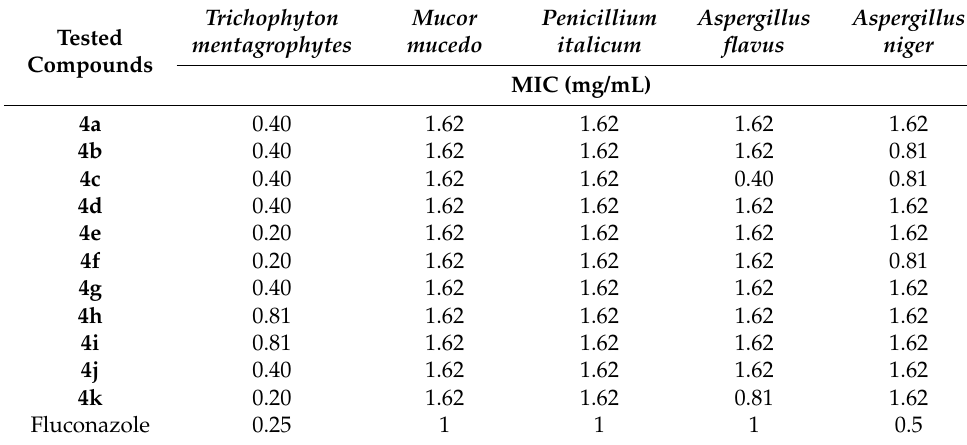
Table 4. The antifungal activity of the tested compounds. Tested